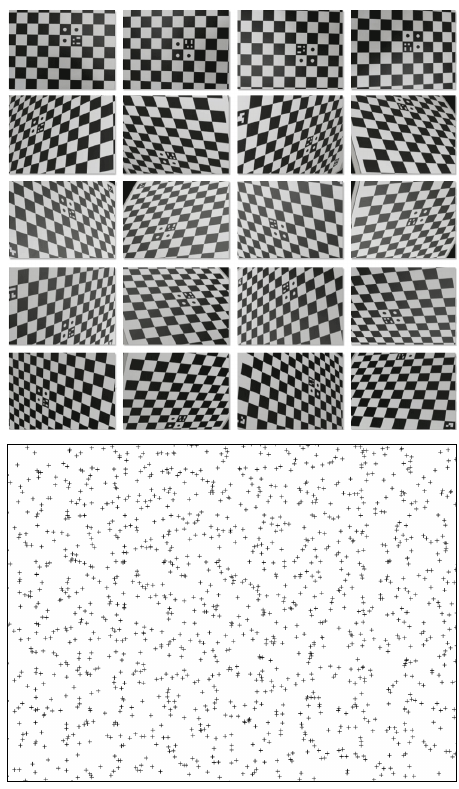
Figure 6: Well distributes corners over the whole image (bottom) due to partially visible chessboard in each image (top) chessboards in order to automate the detection of chessboard cor- ners. These tags are defined as either black or white filled